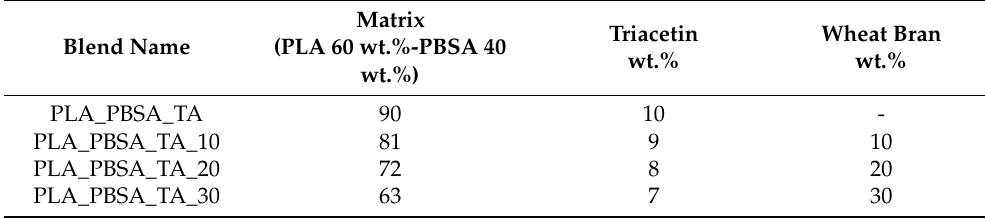
Table 1. Blends name and